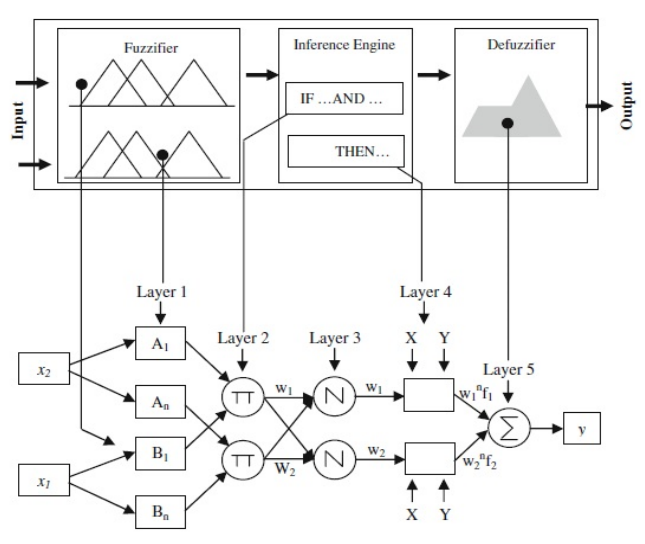
Figure 5. Architecture of ANFIS [11].